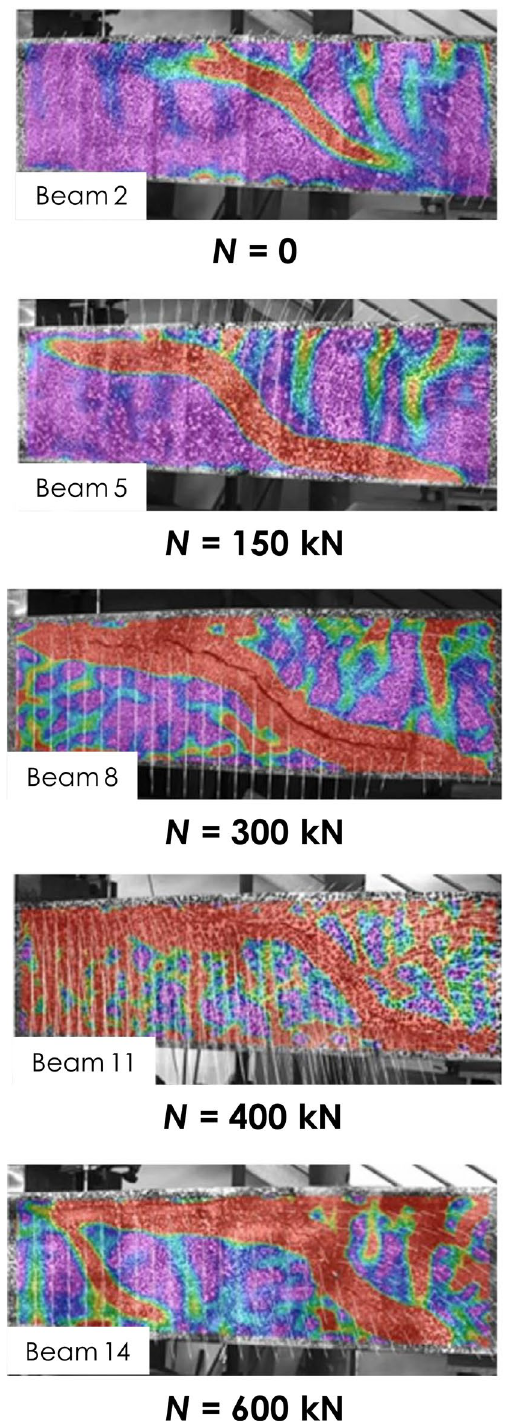
Figure 2. Experimentally observed behavior of RC beams under combined shear and tension 31